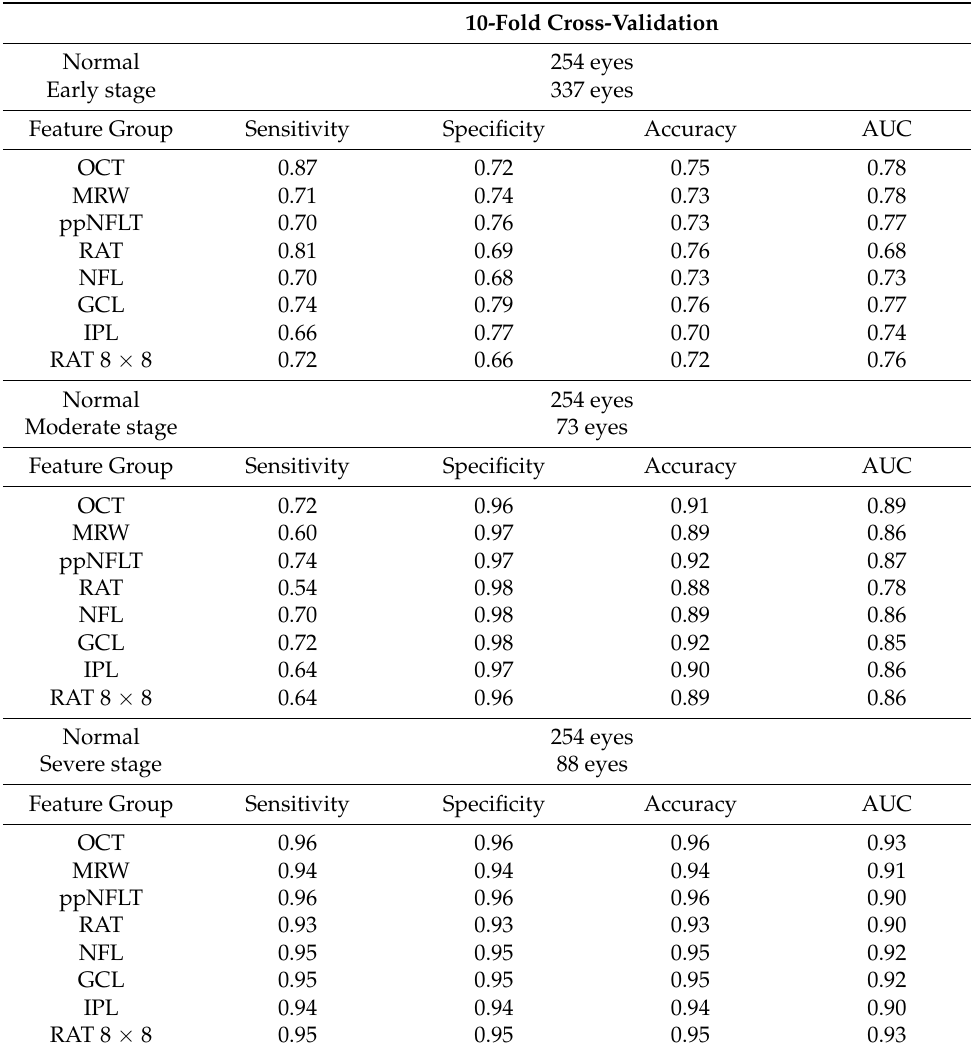
Table 5. SVM classification results between normal and different stage of glaucomatous eyes, using each OCT-related feature